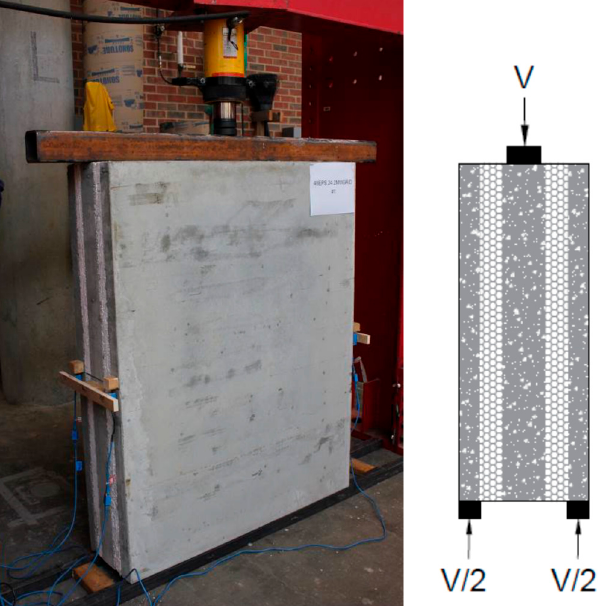
Figure 4. Overview of the test setup ( left ) and schematic of the loading ( right